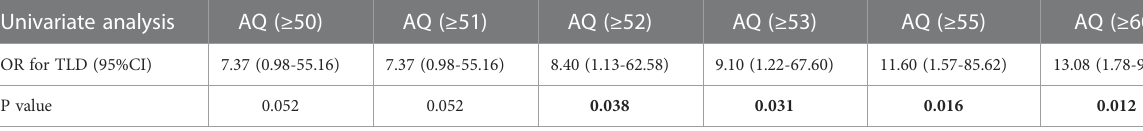
TABLE 4 Optimal AQ threshold in differentiating TLD with no TLD by increments of 1 AQ.